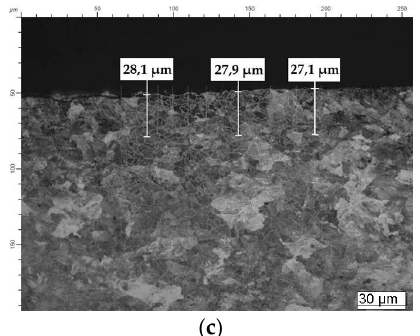
Figure 9. Thickness of the fine grain layer after drawing through α = 6 deg die: ( a ) soft friction condition; ( b ) medium friction condition; and ( c ) hard friction condition. Table 3. Thickness of the fine grain layer.